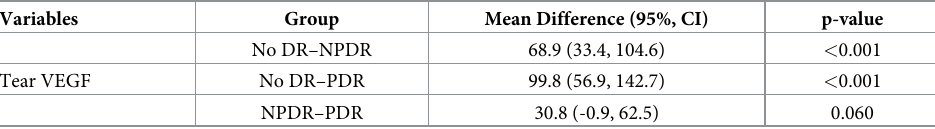
Table 3. Post Hoc comparison of mean tears VEGF after adjustment.